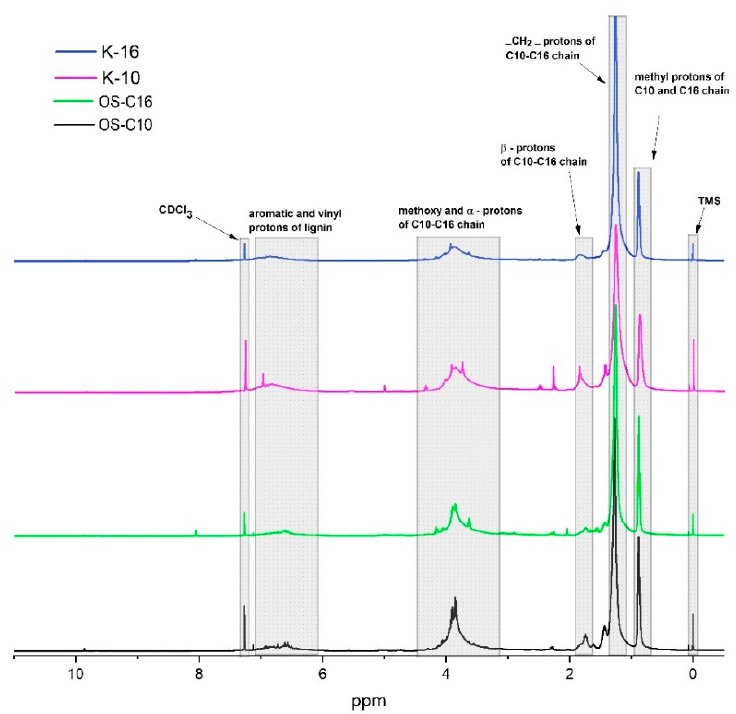
Figure 3. 1 H NMR spectra of functionalized organosolv (OS) and Kraft (K) lignins.